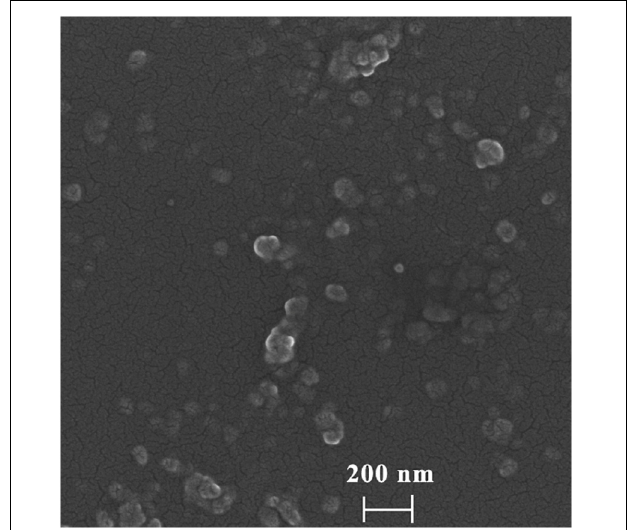
FIGURE 1 | SEM of DHA-CS